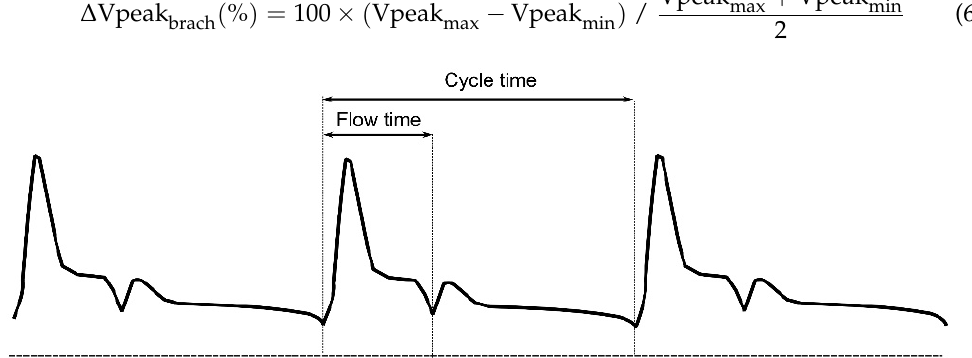
Figure 5. A diagram of the normal spectral Doppler waveform in the common carotid artery showing the measurement of the carotid flow time (CFT). The flow time is measured from the beginning of the carotid upstroke to the central portion of the dicrotic notch. The corrected carotid artery flow time (CFTc) is calculated using the Bazett’s formula explained above.